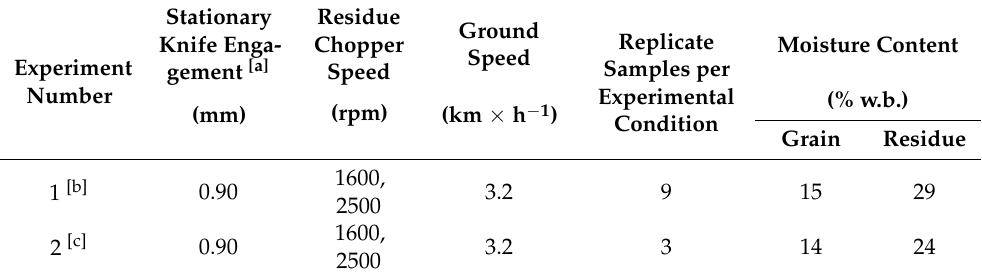
Figure 4. Schematic of combine harvester residue chopper showing stationary knife in full 90 mm radial engagement ( A ) and 0 mm engagement ( B ) positions. Table 2. Combine harvester experimental conditions for material collected for separation with developed screener.